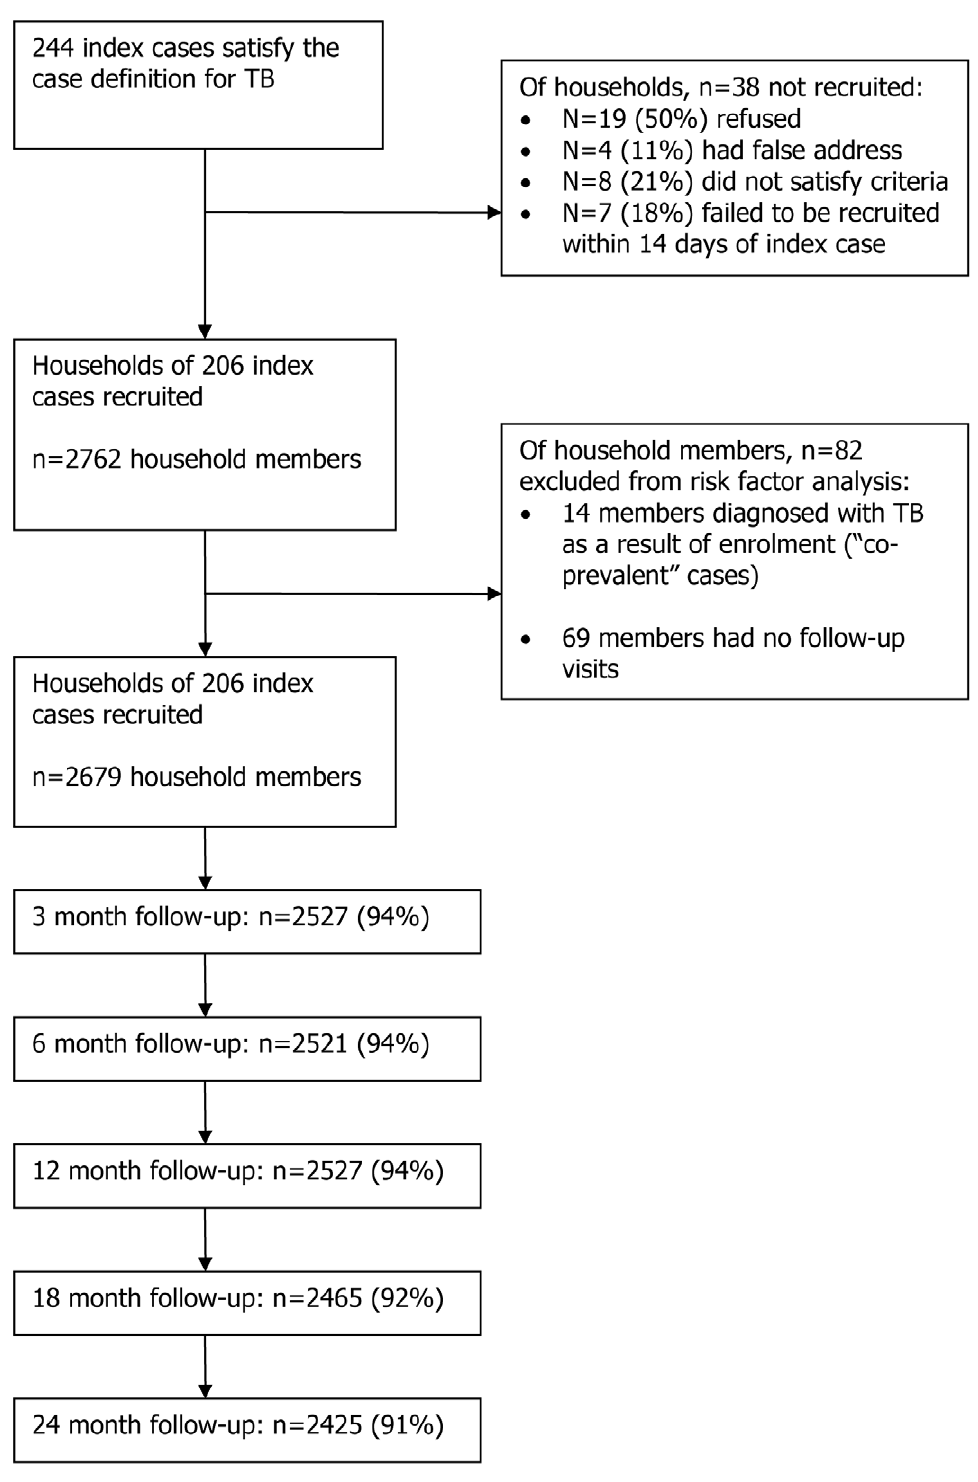
Figure 1. Study Profile.